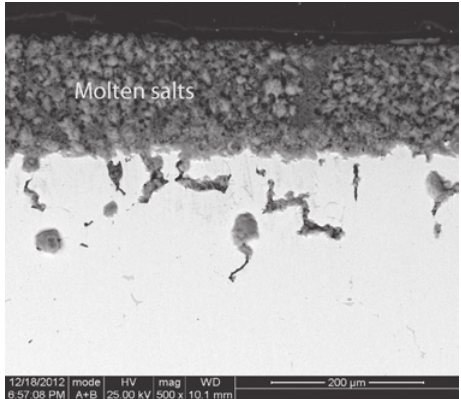
Fig. 8: Cross-sectional morphology of pure Nickel after immersion in molten (Li,Na,K)F at 973 K for 50